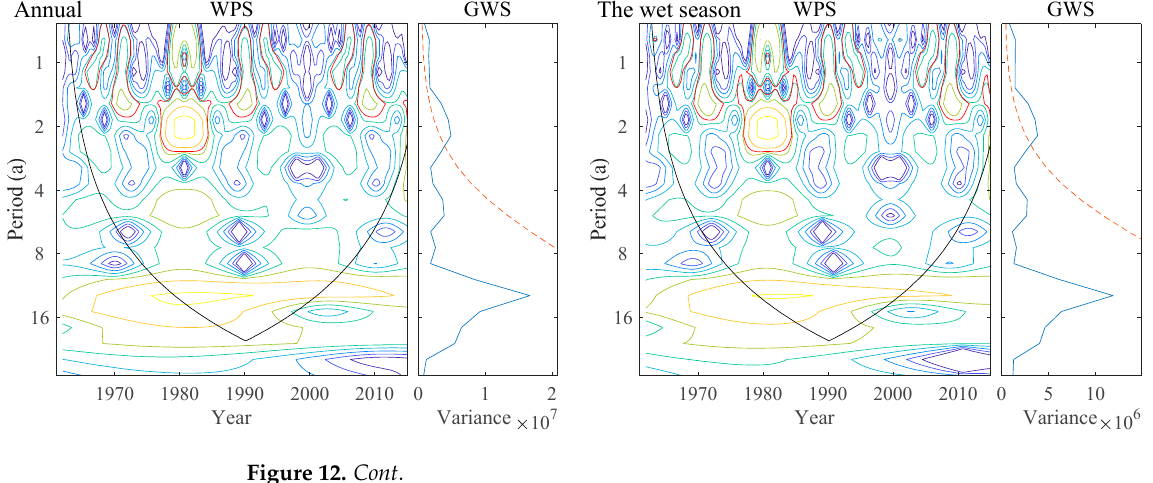
Figure 11. The runoff wavelet power spectrum and global wavelet spectrum for Beiwang station. The wavelet power spectrum and global wavelet spectrum for Dawenkou hydrological station are shown in Figure 12. The oscillation periods of the interannual and wet season runoff series were generally consistent. The range of the significant period was 0.7–2.6 years, there was a main period of 2.2 years, and the variation was most significant over the period 1977–1984. Additionally, there was a significant period of 0.8 years and non-significant periods of about 5.3, 7.5, and 12.6 years. During the dry season, the significant period for the runoff ranged 0.8–2.7 years, there was a main period of 2.2 years, and the variation was most significant over the periods 1963–1967, 1976–1984, 1993–1998, and 2000–2005. There were non-significant periods of about 5.3, 7.5, and 12.6 years.